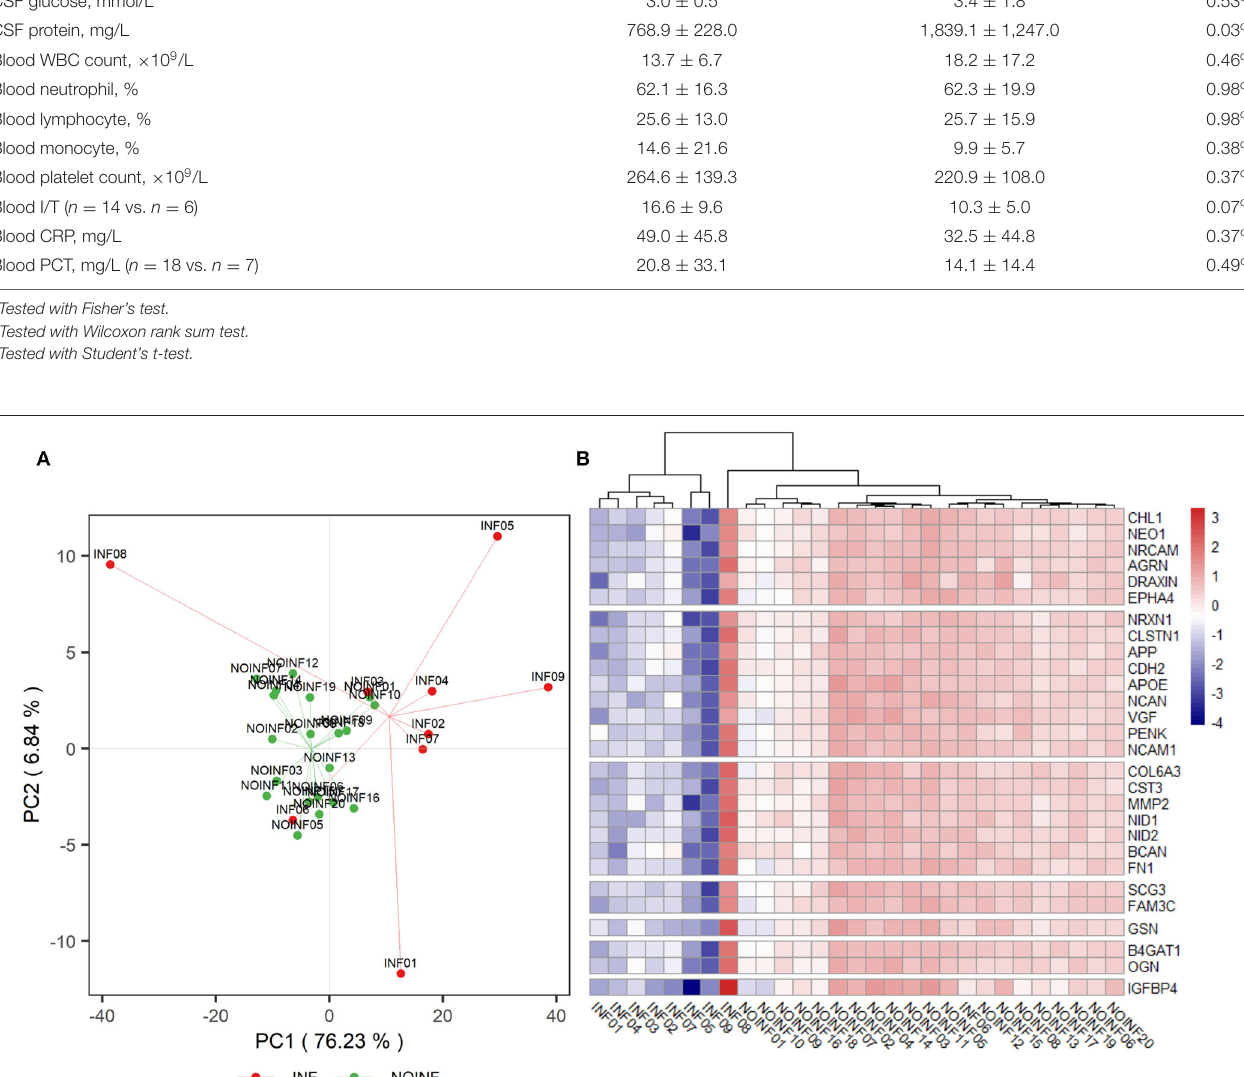
Frontiers in Cellular Neuroscience |